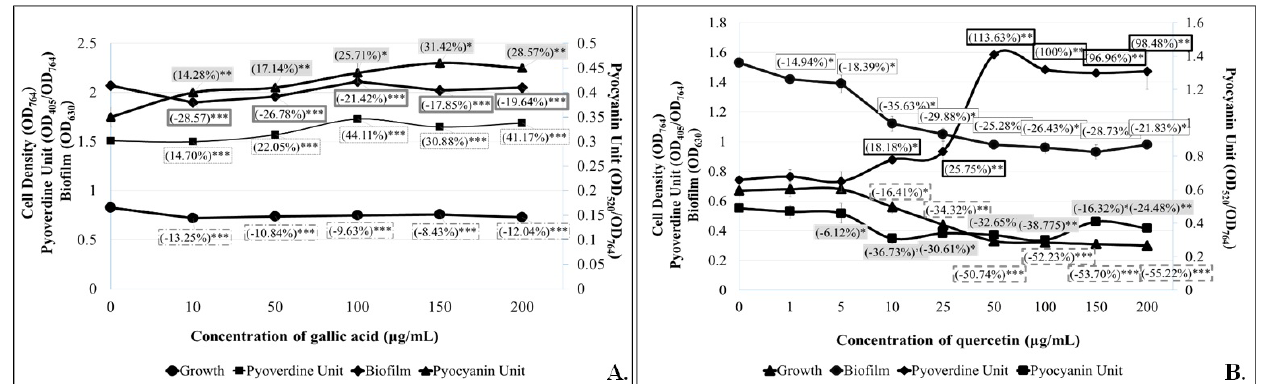
Figure 8. Effect of GA and quercetin on various traits of P. aeruginosa, in vitro . ‘Control’ in this figure is the vehicle control (0.5%v/v DMSO), which did not exert any effect on growth and pigment production of P. aeruginosa; Bacterial growth was measured as OD